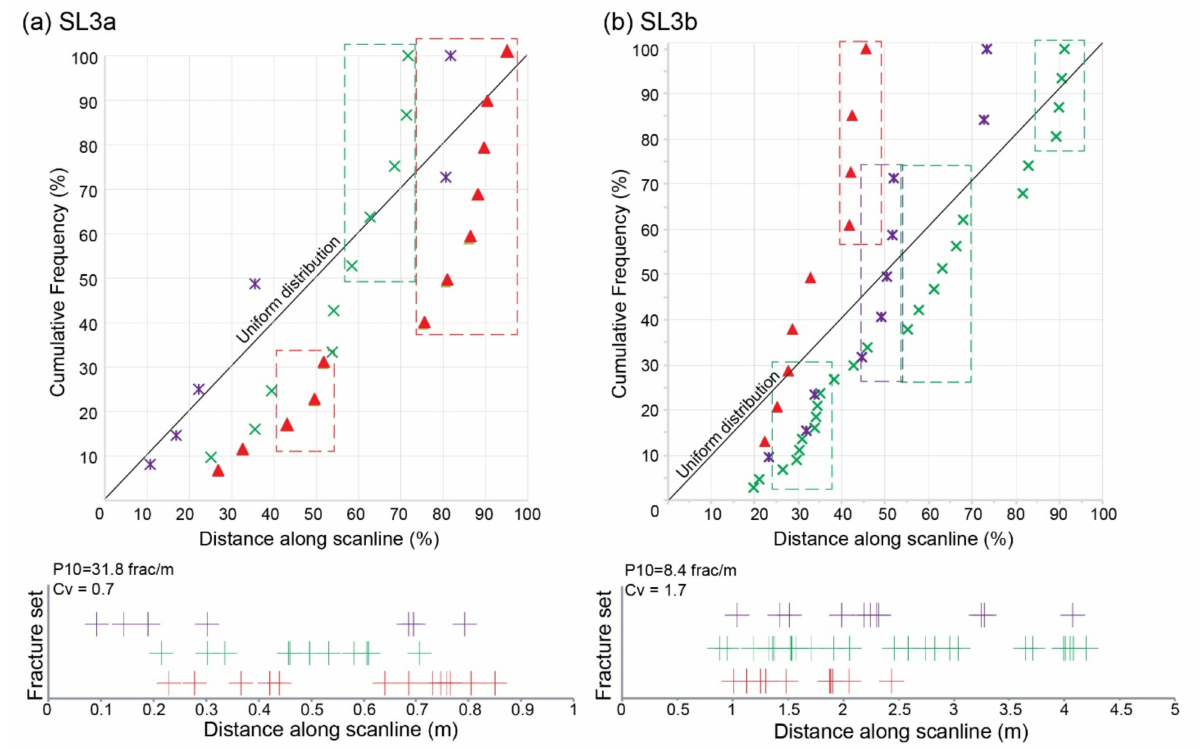
Figure 7. Cumulative frequency diagram along each scanline and following each fracture set (in colors). Plot of cumulative frequency expressed in % versus distance along scanline for: ( a ) SL3, and ( b ) SL3a. Dashed lines indicate a potential cluster for each fracture distribution, indicating a rapid increase in the number of fractures with slope threshold > 2. The diagonal line in each plot of cumulative frequency defines a uniform or regular distribution. Visual location of fractures expressed in stick plots for each fracture set distribution, highlighting the fracture position along the scanline, including the fracture density (P 10 ) and the coefficient of variation (Cv) values. See the color legend in Figure